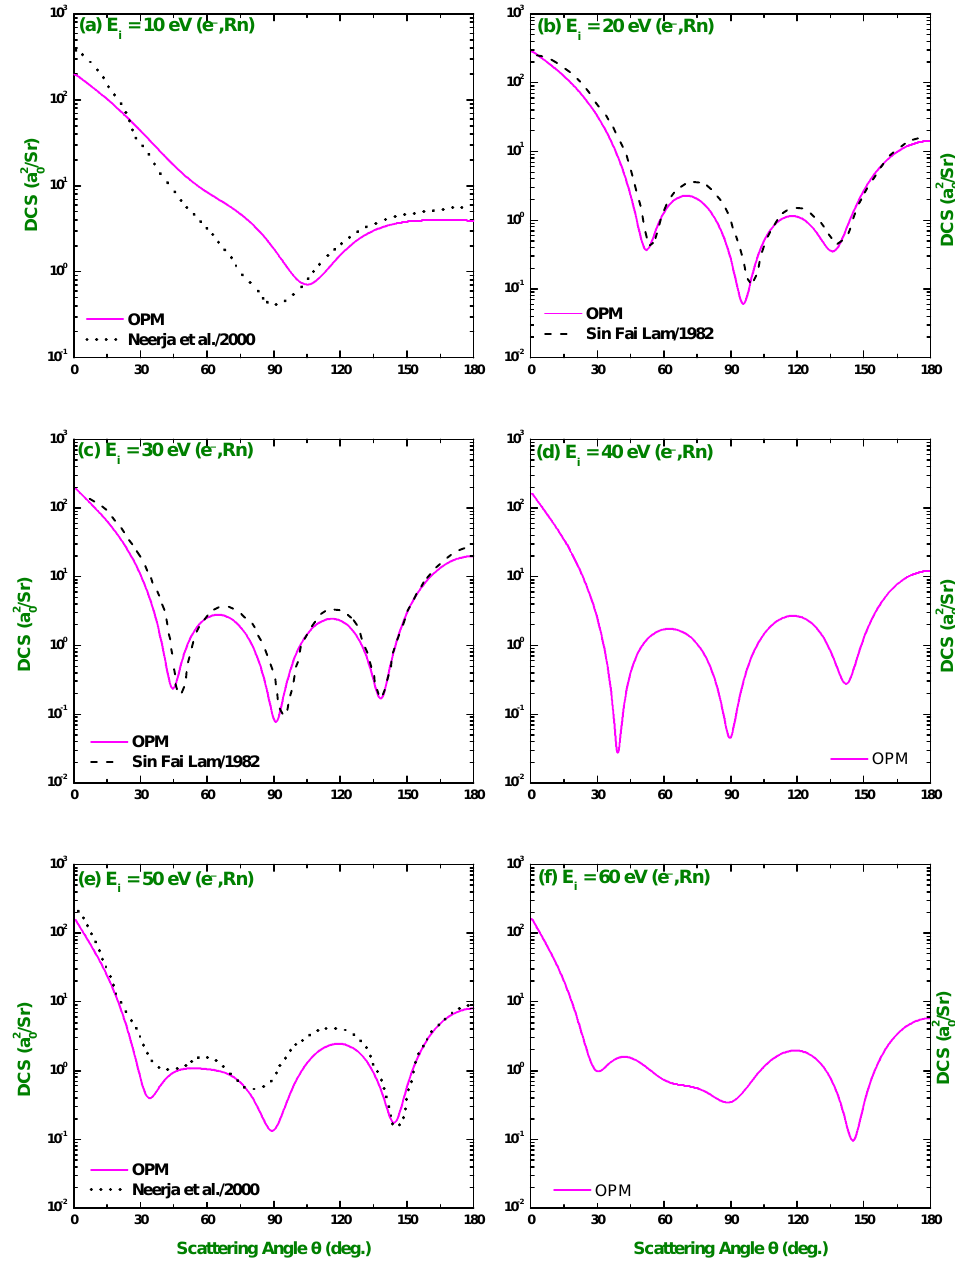
Figure 6. Angular dependence of the differential cross section of electrons scattering from 222 Rn at impact energies E i = 10, 20, 30, 40, 50 and 60 eV. Shown are the results from our MCP (——), Neerja et al. [19] ( · · · · · · ) and Sin Fai Lam [13] ( − − −